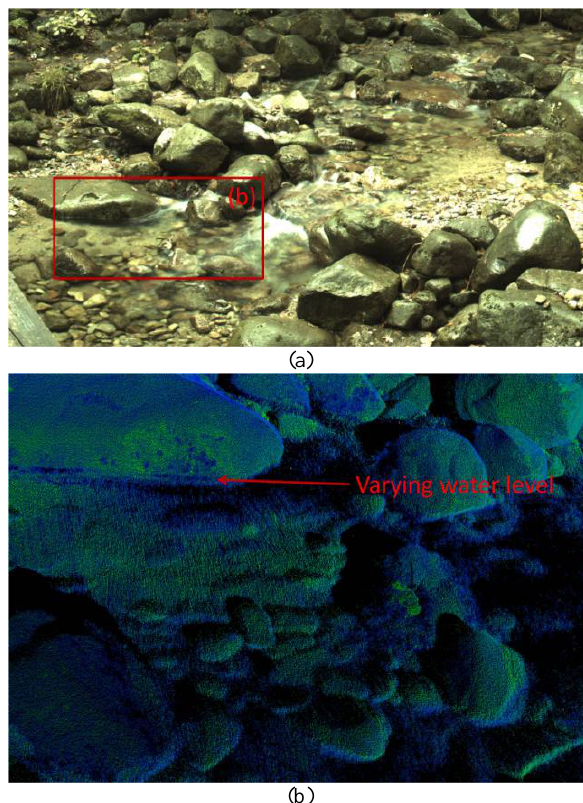
Figure 5. Scanning through the water: (a) turbulent water flow, (b) noisy point